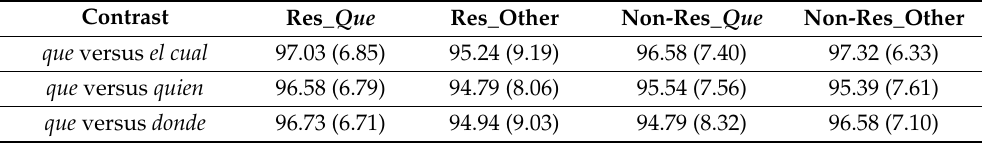
Table 5. Mean accuracy rates (%) and SD (in parentheses) to comprehension questions by contrast and condition. “Res” refers to restrictive RCs and “Non-Res” to non-restrictive RCs. Similarly, “Other” refers to the relativizer that is compared with que in each contrast: El cual , quien, or donde . Contrast Res_ Que Res_Other Non-Res_ Que Non-Res_Other que versus el cual 97.03 (6.85) 95.24 (9.19) que versus quien 96.58 (6.79) que versus donde 96.73 (6.71) 96.58